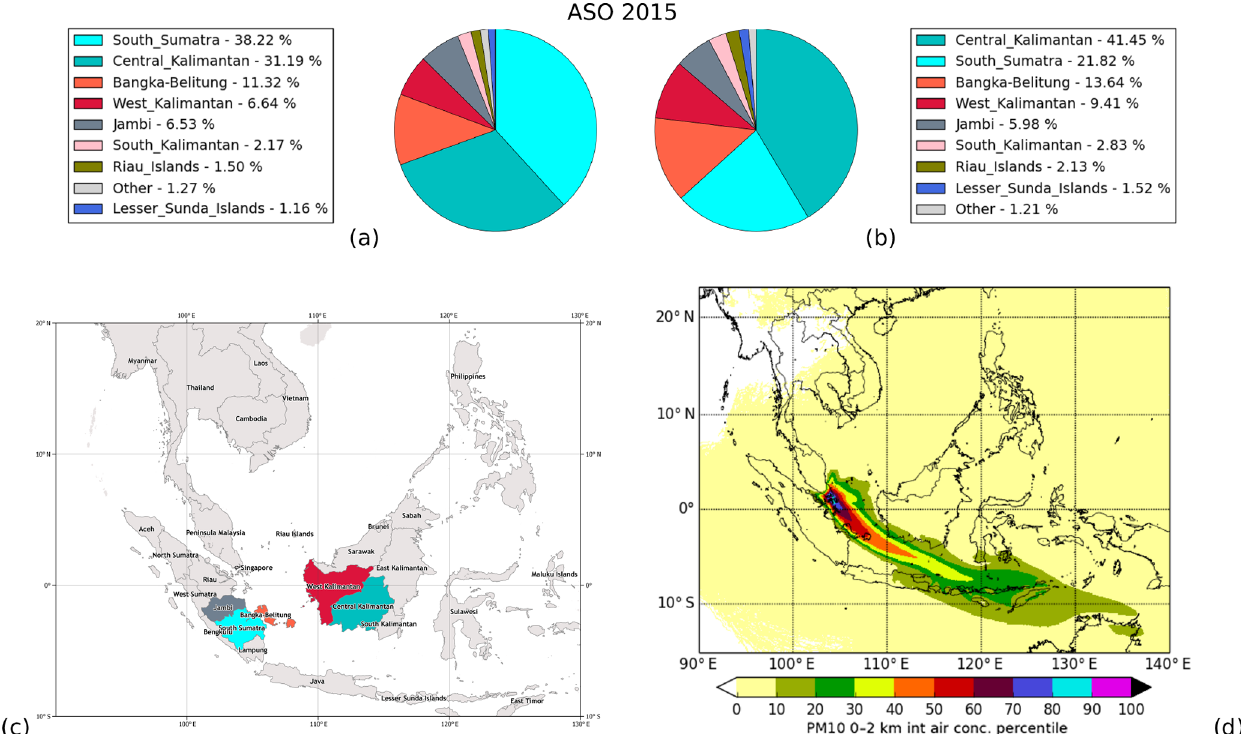
Figure 8. This figure shows results for PM 10 for ASO 2015: pie charts for the western (NTU) (a) and eastern (TP) (b) monitoring stations showing major contributing source regions, (c) the regional map highlighting only the major contributing source regions, and (d) the air history map showing where the air arriving in Singapore originated from in ASO 2015. The “Other” category in the pie charts is from sources which individually contribute less than